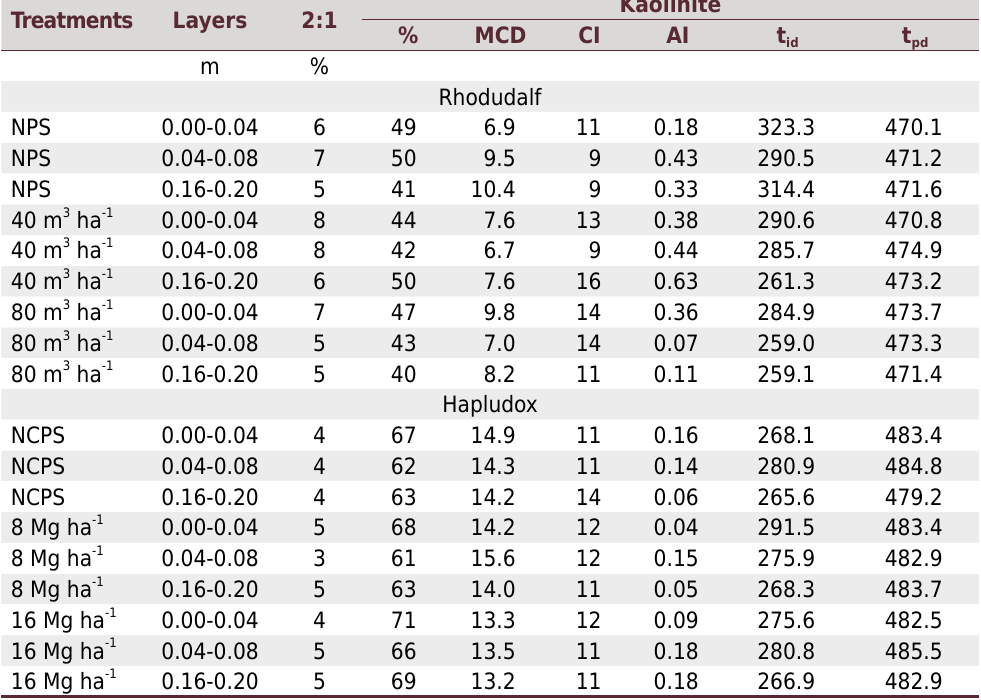
Table 4. Crystallographic data of kaolinite and the amount of 2:1 minerals of the Typic Rhodudalf and Typic Hapludox under long-term organic fertilization in no-tillage systems Treatments